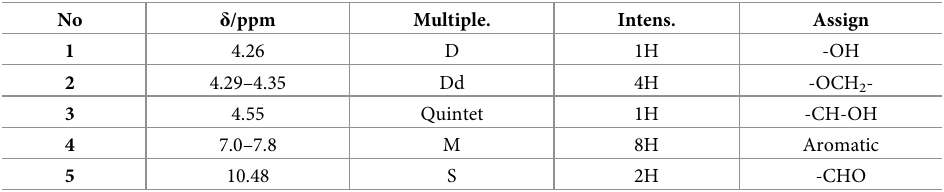
Table 2. Shows the H1-NMR data of compound